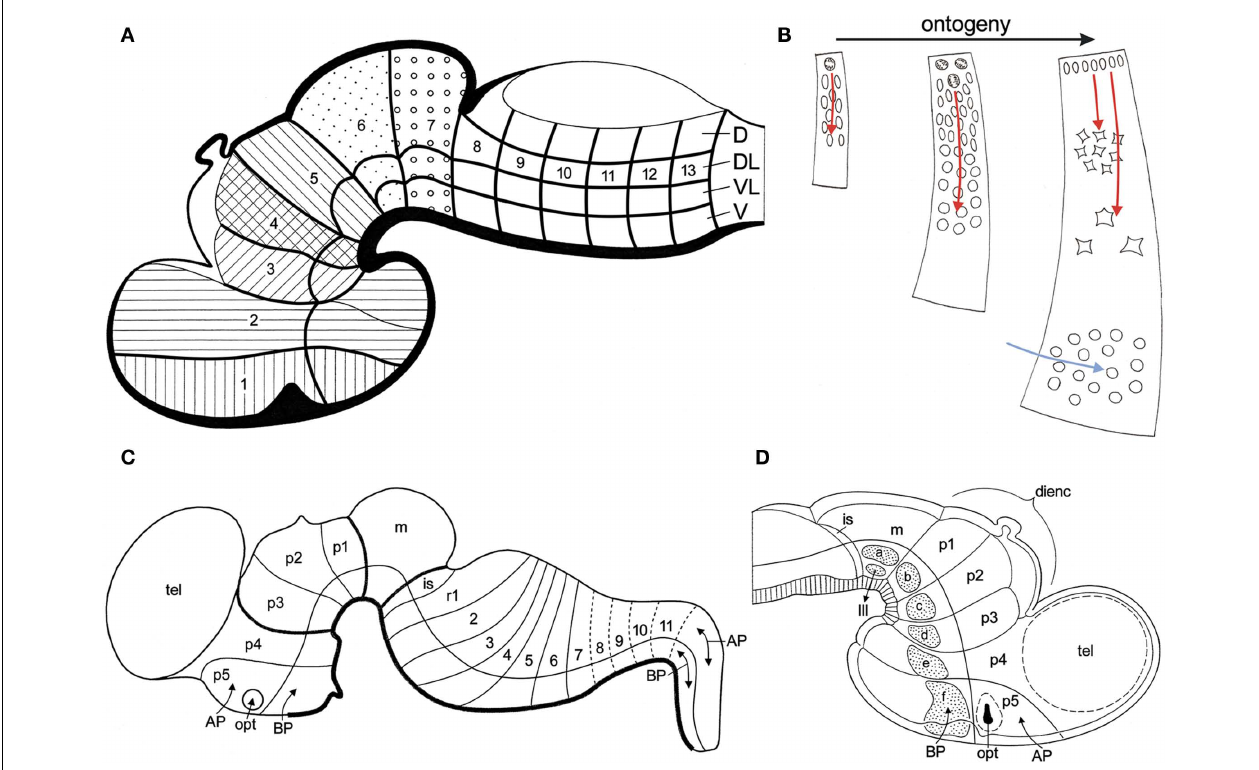
arrows). During later development, tangentially migrating neuroblasts, originating from other sources, may invade a given unit (blue arrow). (C) Schema of the brain of a mammalian embryo.The longitudinal and transverse delineations are primarily based on the expression patterns of a number of developmental regulatory genes. Based on Puelles et al. (2007). (D) Diagrammatic median section through the rostral part of the brain of a chick embryo. Distinct groups of early differentiating neuroblasts manifest themselves in the basal plate sections of the midbrain segment (m), and of the five prosomeres (p1–p5). Modified from Puelles et al.